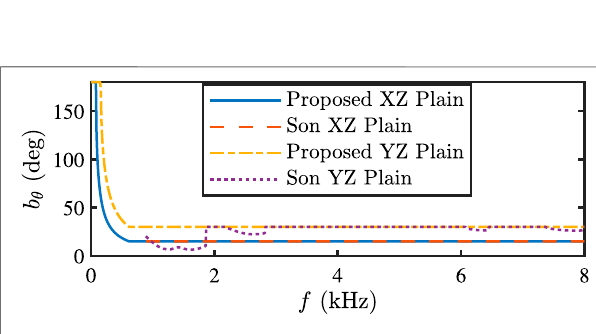
FIGURE 10 | Beamwidths in the XZ and YZ planes as a function of frequency of Son ’ s and our proposed planar beamformers.